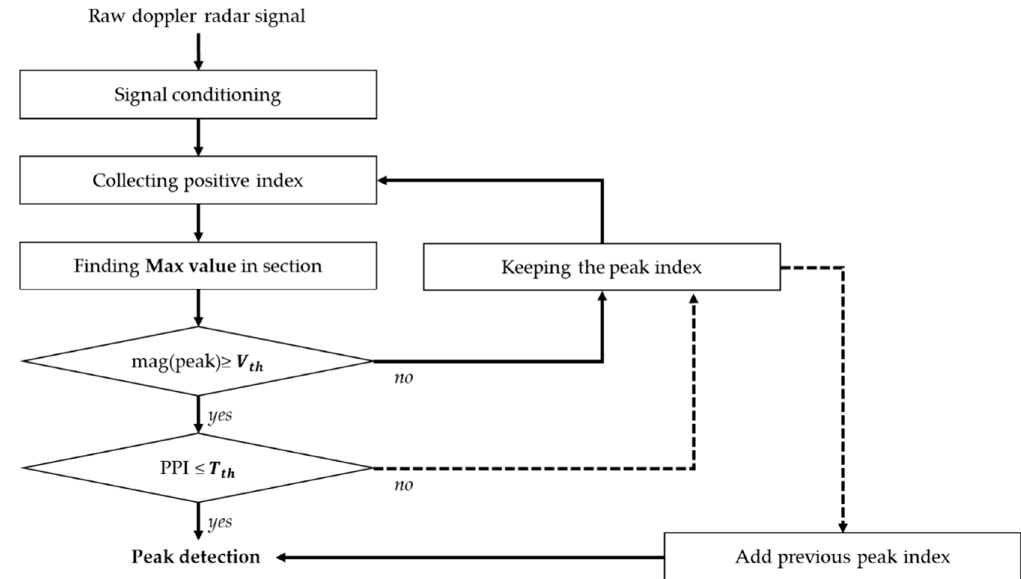
Figure 4. Overall flowchart of the proposed peak detection algorithm.